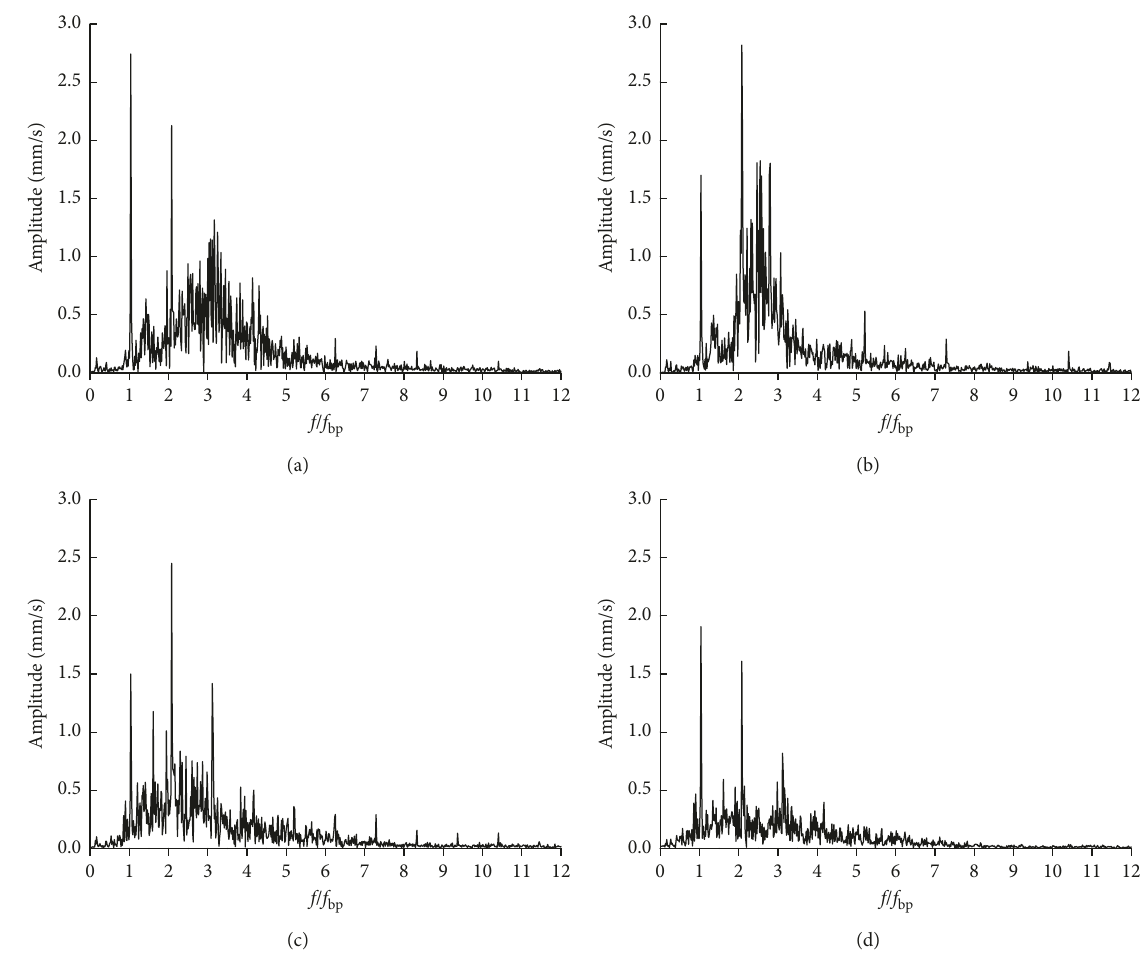
Figure 6: Vibration spectrum at the zero flow rate: (a) CH3; (b) CH4; (c) CH5; (d) CH6.